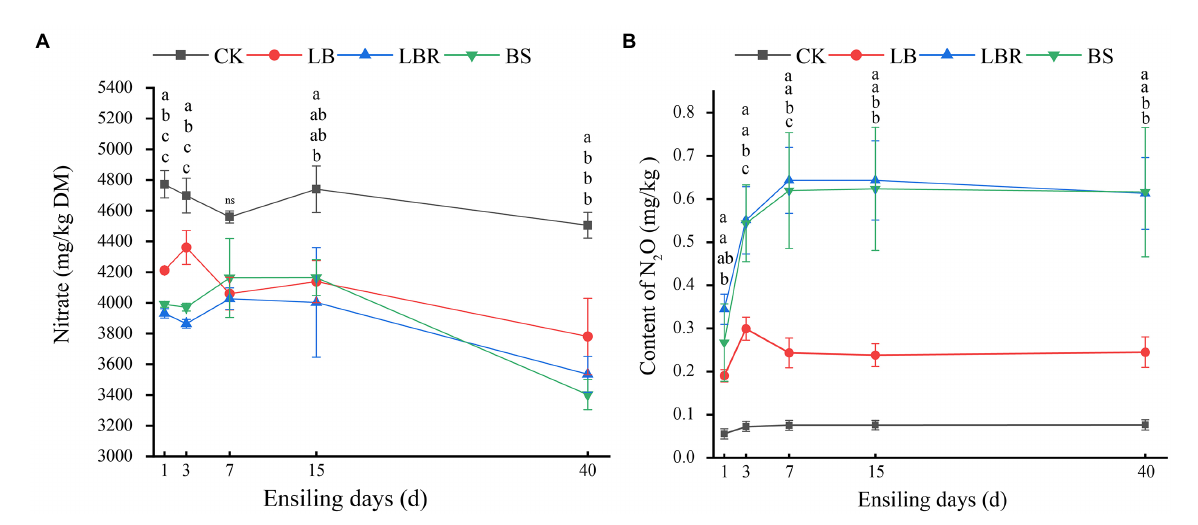
FIGURE 5 The nitrate content (A) and N 2 O (B) content in sorghum-sudangrass after ensiling for 1, 3, 7, 15, and 40 days (CK, control; LB, Lactobacillus buchneri ; LBR, Lactobacillus brevis; BS, Bacillus subtilis; different lowercase indicate differences between treatment groups at the same time at the 0.05 level; ns, mean no significant